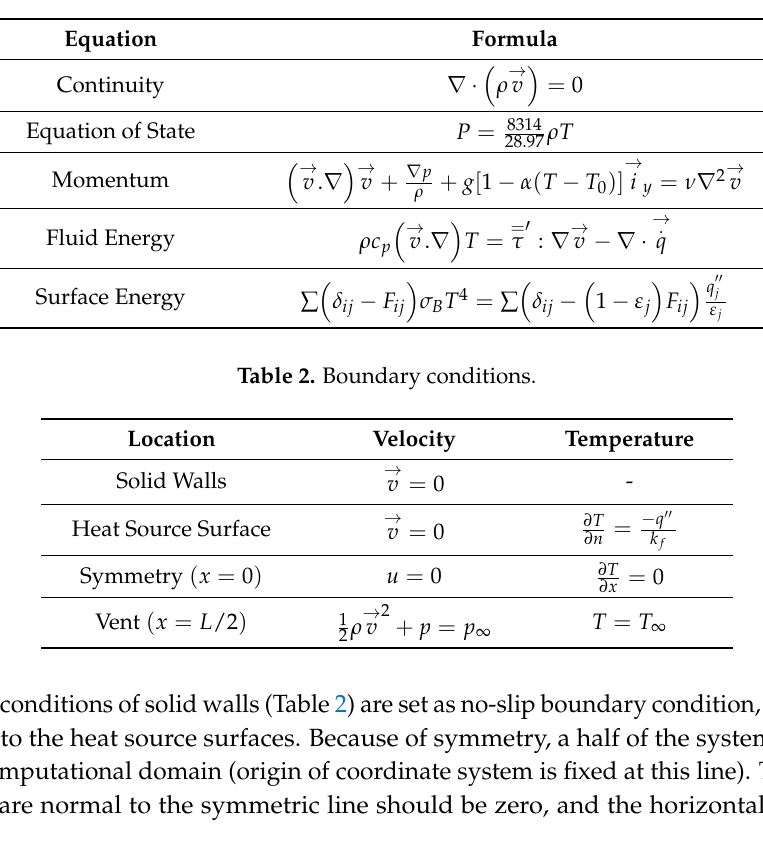
Figure 1. Open cavity with discrete heat sources. Table 1. Summary of equations.